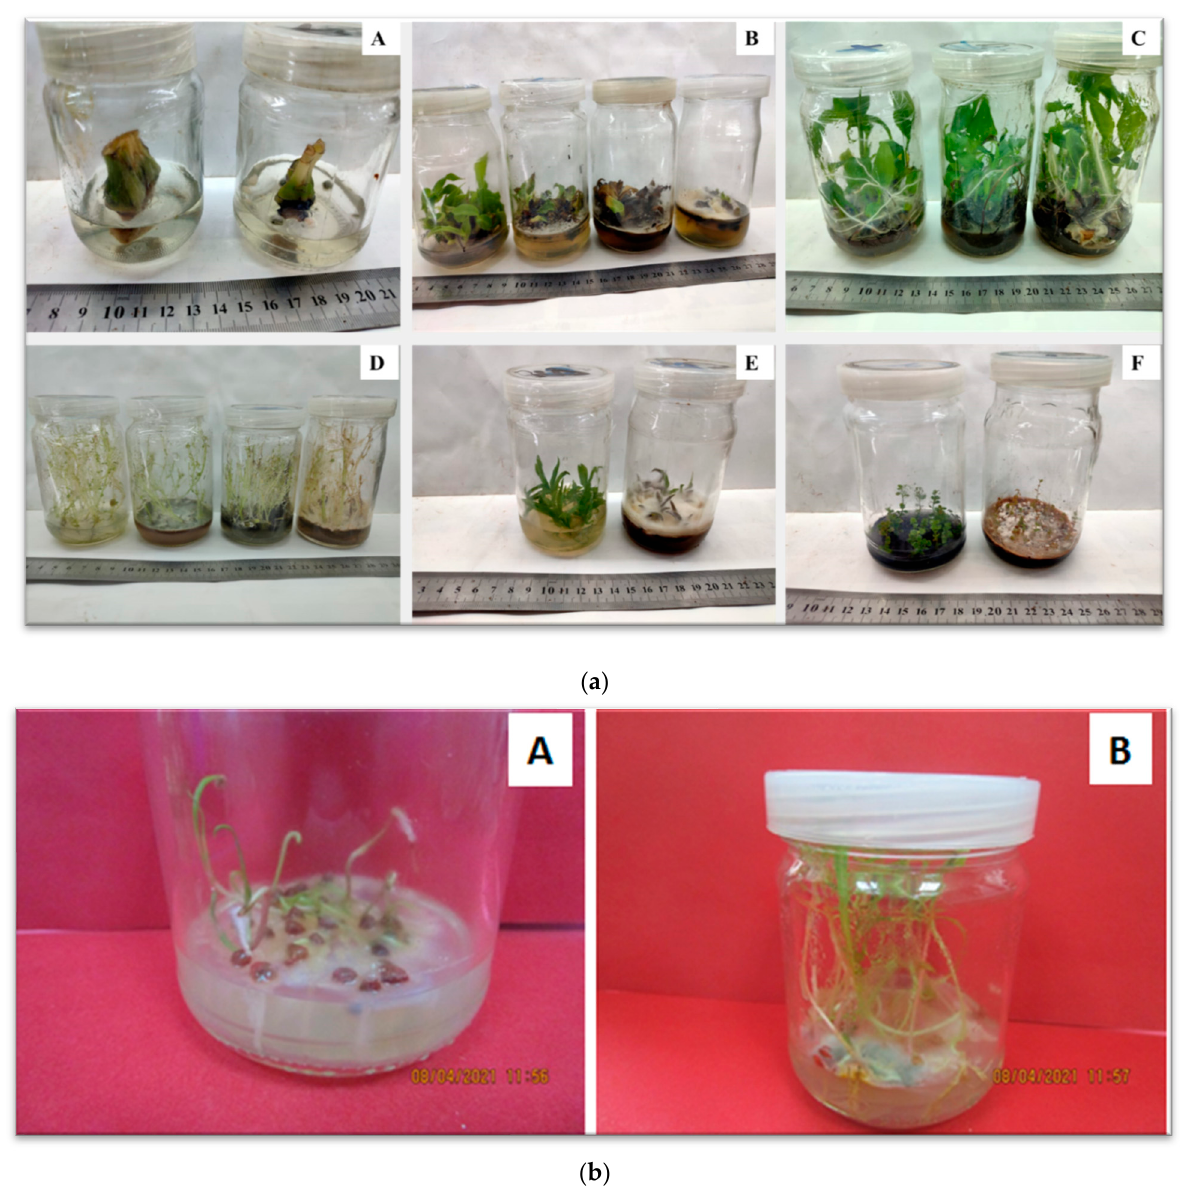
Figure 2. ( a ) Effect of contamination on in vitro plants (left jar = normal plant, right jar or jars = contaminated plant). ( A ) Banana plant ( Musa sp.) at initiation stage of meristem culture, ( B ) banana plant at shoot multiplication stage, ( C ) banana plant at rooting stage, ( D ) potato plant ( Solanum tuberosum L.), ( E ) Cattleya sp., and ( F ) blueberry ( Vaccinium corymbosum L.) at rooting stage. ( b ) Effect of contamination on in vitro growth and shoot proliferation of spinach plant ( Spinacia oleracea L.) ( A ) = Bacterial contamination and ( B ) = fungal